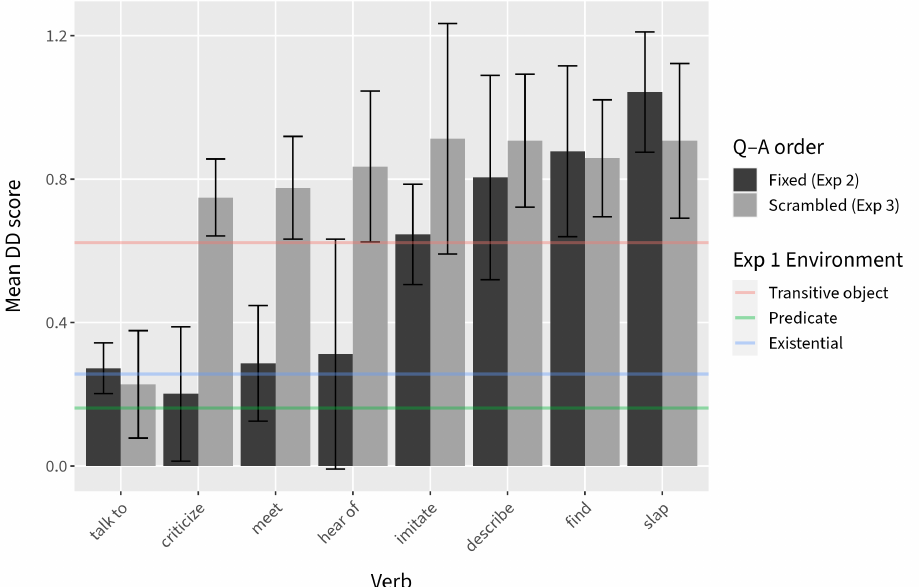
Figure 9. DD scores (calculated from z-scored ratings) by verb and Q–A order (Experiment) with Experiment 1 DD scores overlaid as horizontal lines. Error bars represent the standard error over DD scores calculated by item. Summary statistics are based on five to six DD scores calculated per verb per experiment. See z-scored ratings by item in Appendix